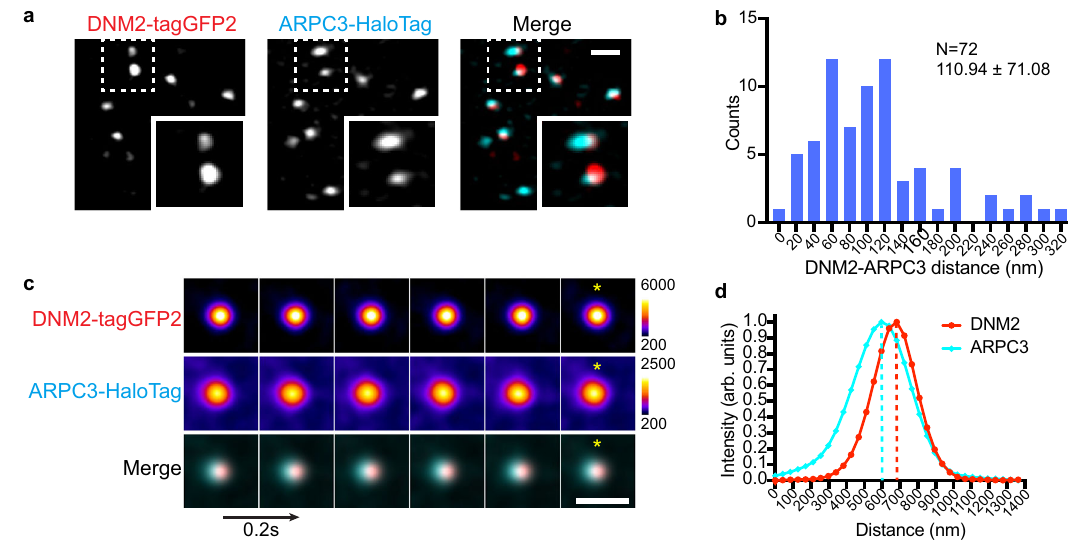
Fig. 3 Airyscan live-cell imaging reveals asymmetric actin organization at CME sites. a A representative single time frame image of an Airyscan movie (Supplementary Movie 3) of DNM2-tagGFP2 (red) and JF635 ligand-conjugated ARPC3-HaloTag (cyan) on the ventral plasma membrane surface of ADA cells. The highlighted region is boxed by a dashed line. Scale bar: 1 µ m. b Histogram of distance between the center of mass of DNM2 and ARPC3 at frame corresponding to scission. Mean and standard deviation are shown on the graph. Data were analyzed using Prism 9. Source data are provided in the Source Data fi le. c Montage of average intensity projection of representative ARPC3 positive CME sites. Frame corresponding to scission was determined by maximum DNM2 intensity. 33 × 33 pixels square region centered at DNM2 maximum intensity pixel was cropped for six continuous frames ending in scission. Cropped frame series were rotated by 90 or 180 degrees as needed to align the ARPC3 signal to the left of the center of the image at the frame corresponding to scission. *: Averaged image of the frame corresponding to scission (maximum DNM2 intensity) is marked to show the displacement between the CME neck (DNM2) and branched actin (ARPC3). Scale bar: 1 µ m. Intervals: 0.2 s. N = 72. d The line scan function in ImageJ software was used to measure the fl uorescence intensity along a one pixel wide, 33 pixel long horizontal line drawn across the center of the averaged intensity image of the frame corresponding to scission* in c . The signals were normalized to the minimum signal along the line, and intensity was calculated as a ratio to the maximum signal along the line. Source data are provided in the Source Data fi